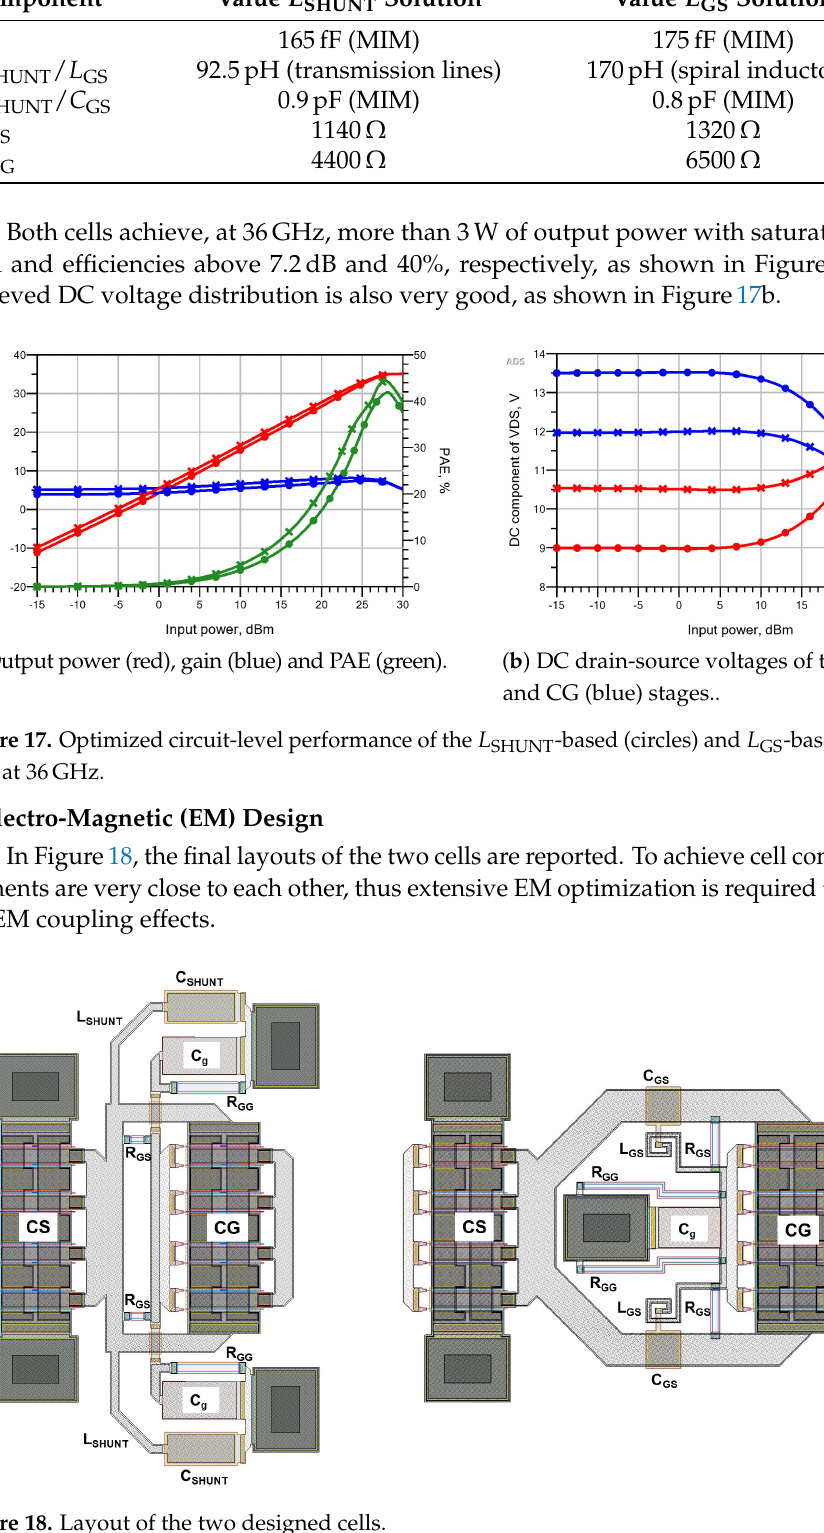
Figure 18. Layout of the two designed